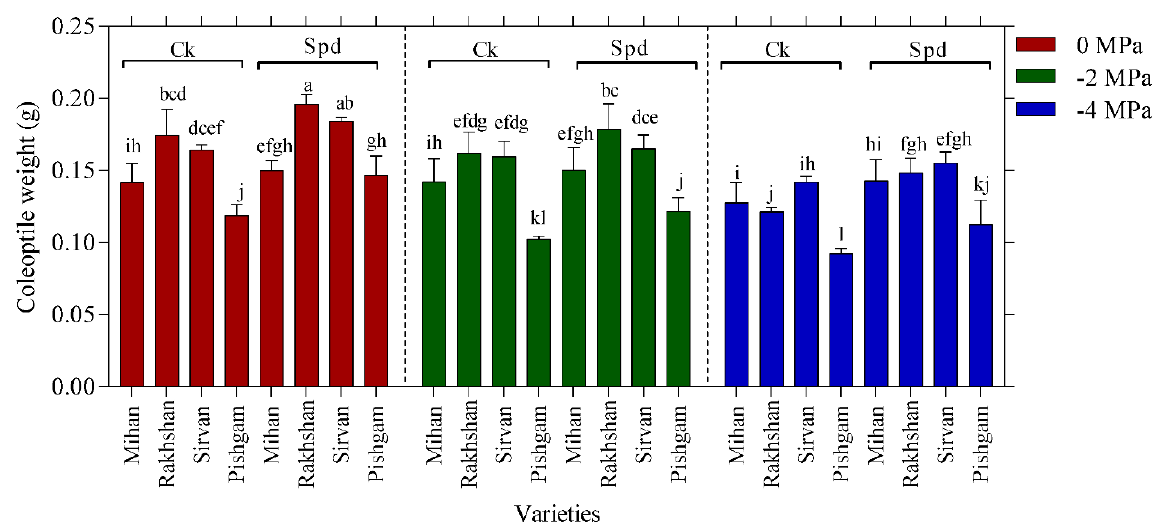
Figure 4. Effect of spermidine (Spd) on coleoptile weight of four wheat varieties under drought stress with three levels of PEG 6000 osmotic potential ( − 2, − 4 MPa and 0 using distilled water as control). Ck = distilled water. Different letters indicate statistically significant differences across all three levels of PEG 6000 at p < 0.05 level using LSD’s test.